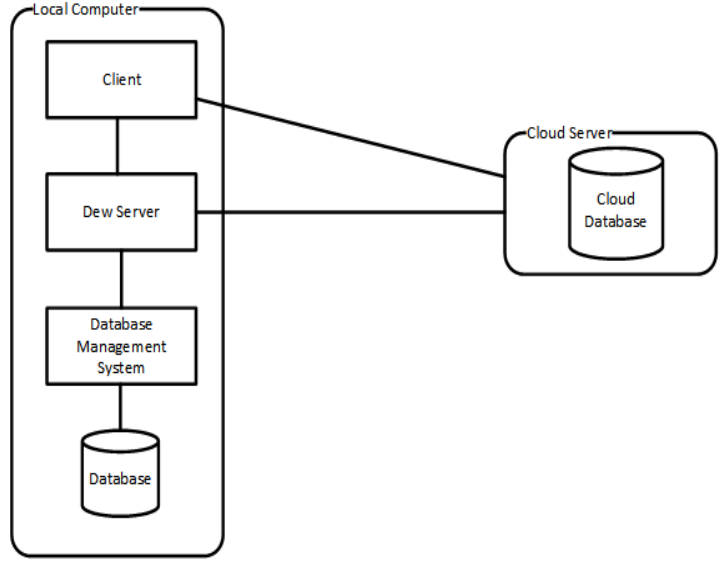
Figure 2. Cloud-dew architecture